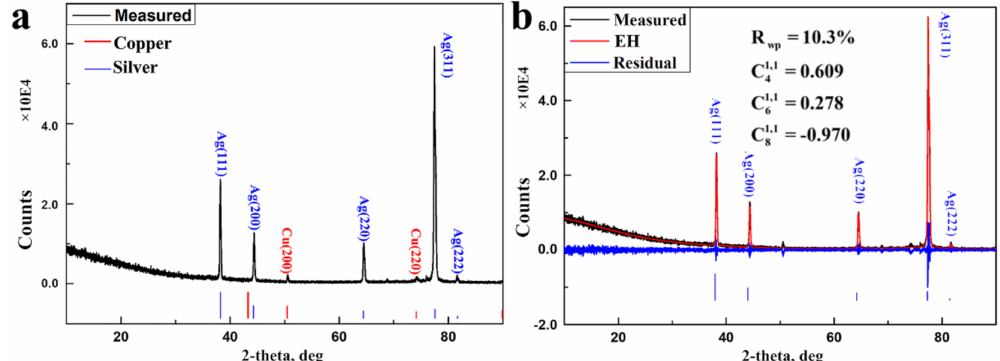
Figure 1. ( a ) Measured θ /2 θ diffraction profile of silver plating on the copper substrate; ( b ) the agreement between measured and calculated XRD profile for silver phase following Rietveld refinement with exponential harmonics description (EH) for preferred orientation